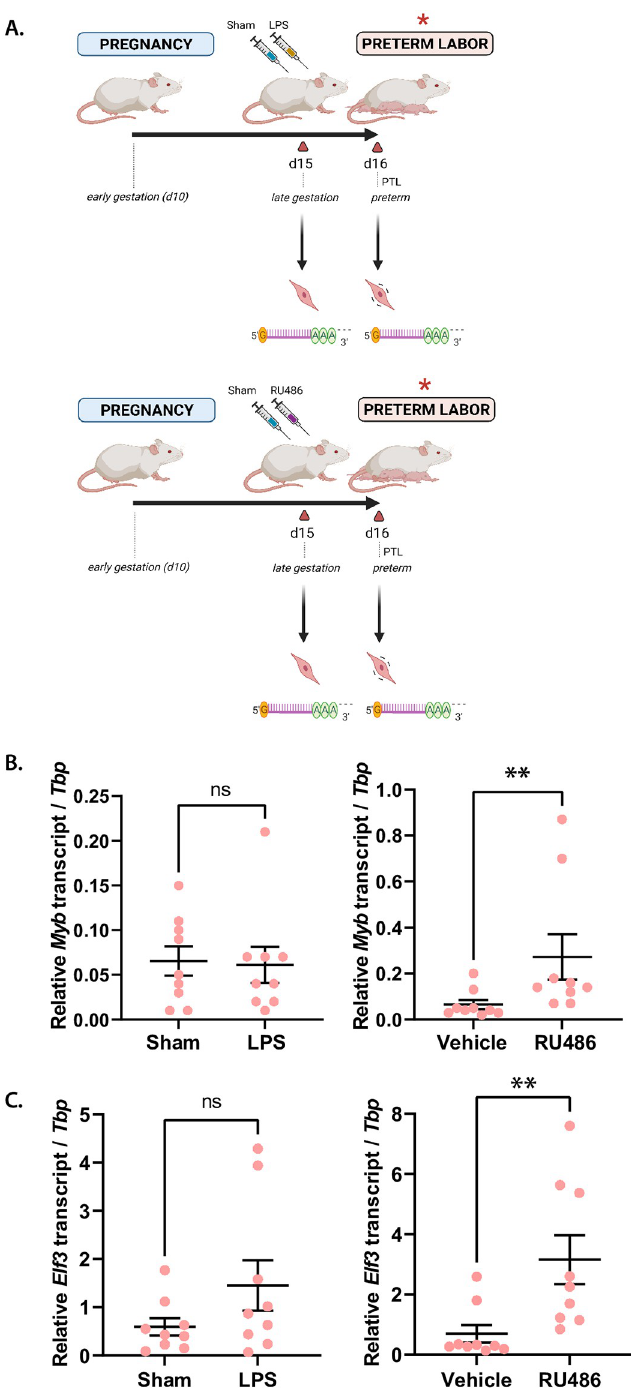
Fig 2. Myb and Elf3 are up-regulated at labor onset in the RU486-, but not in the LPS-induced preterm labor model. (A) Schematic of gestational time points of interest for RNA collection from CD-1 mouse myometrial tissues in two preterm labor models: local infection-simulating inflammation (LPS) and progesterone withdrawal (RU486). Gestational days (d) at which tissues were collected marked by triangles (red), with indication of injection with RU486 or LPS alongside vehicle and sham controls, respectively, at d15 and at preterm labor (18–24 hours post-infection (hpi), italicized ). Expression levels ( ± S.D.) of transcription factor-encoding genes Myb (B) and Elf3 (C) in sham- and LPS-treated mice ( left ) and in vehicle- and RU486-treated mice ( right ), as determined by RT-qPCR. Statistically significant differences in expression levels between control and preterm labor are marked by �� p < 0.01.